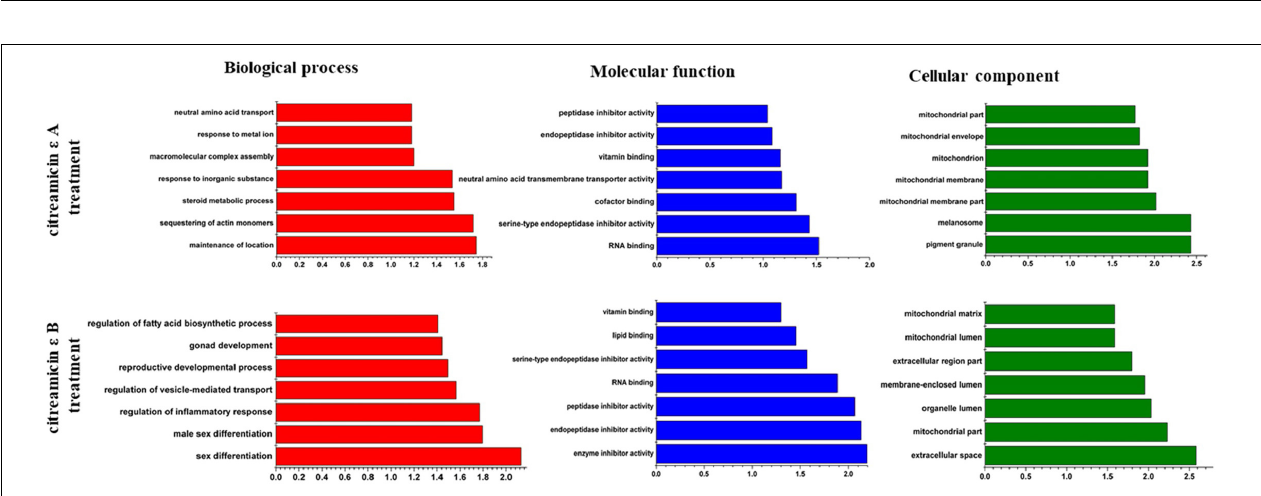
FIGURE 4 | Venn diagrams showing the overlap of the differentially expressed proteins (DEPs) in PtK2 cells with the treatment of citreamicin ε A (A) and B (B) for 6, 12, and 24 h, respectively, and the overlap of the DEPs between citreamicin ε A and B treatment within 24 h (C) .